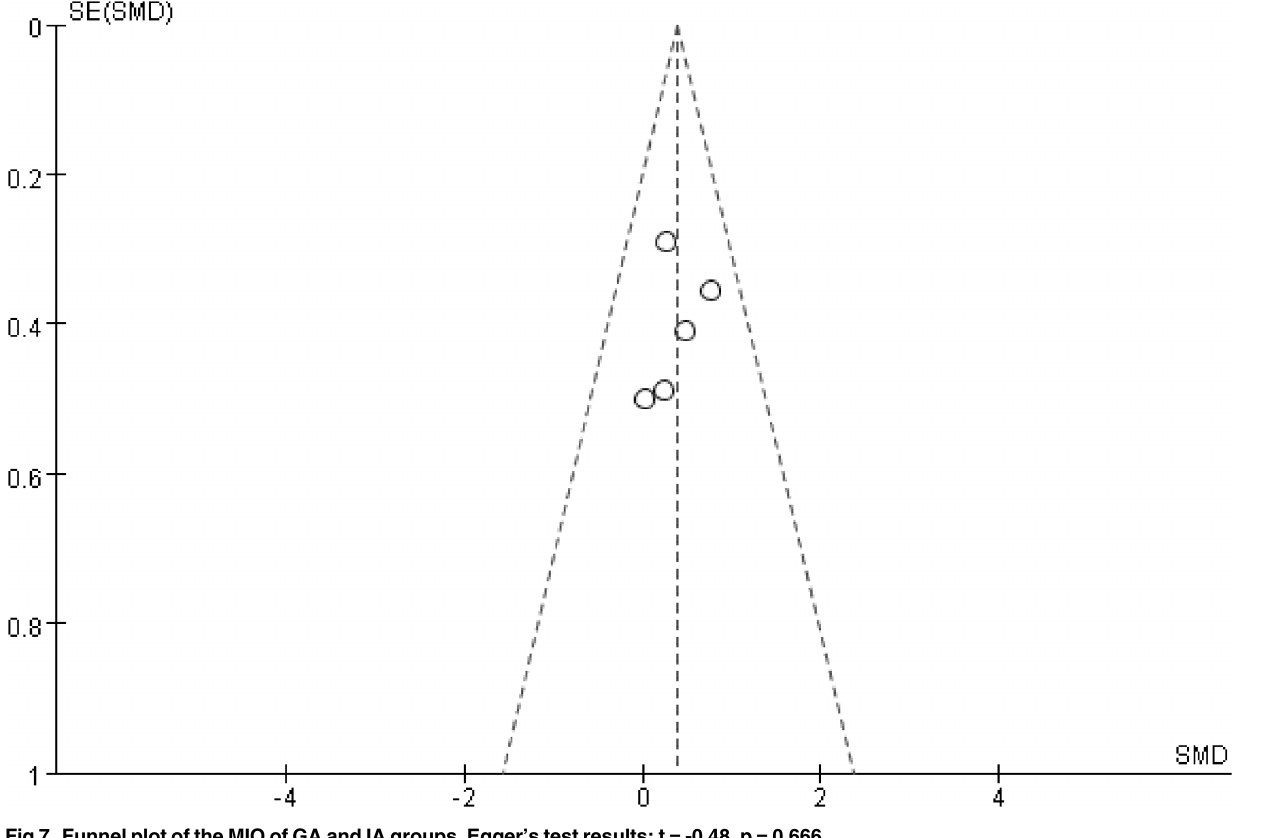
Fig 7. Funnel plot of the MIO of GA and IA groups, Egger ’ s test results: t = -0.48, p = 0.666.